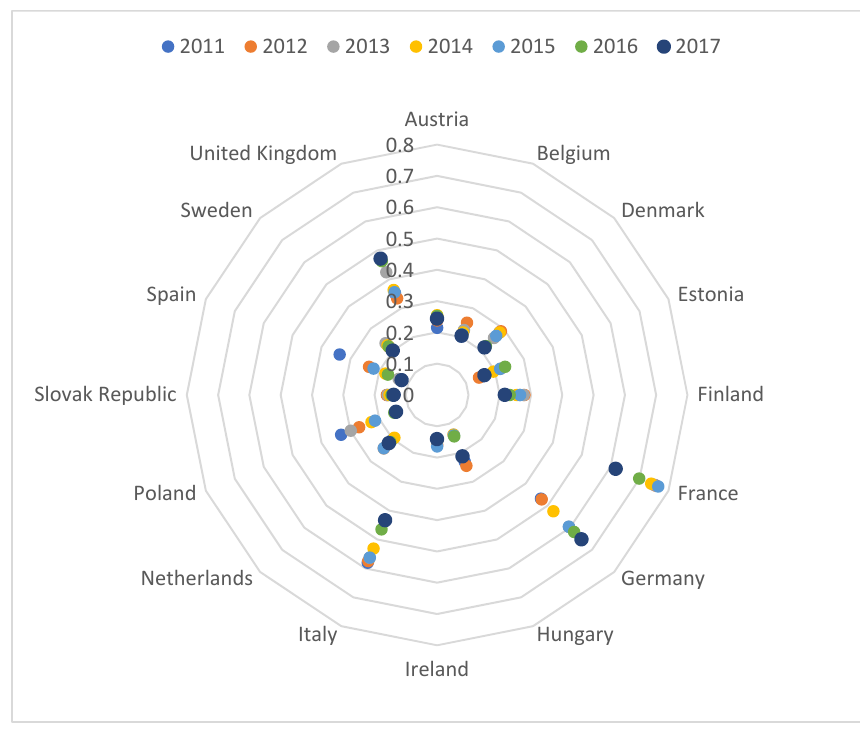
Figure 1. Changes in the SMI value from 2011 to 2017.